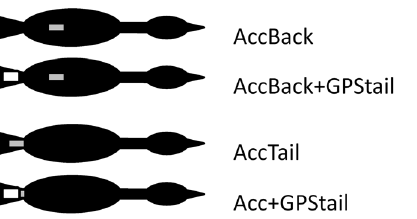
Figure 1. Dorsal placements of external devices fitted to gannets. Schematic representation of a gannet wearing devices at different positions as to test the effect of device mass and placement on flying behaviour and energetics. NB All devices placed on the tail were attached to the underside of 2 to 3 central feathers using Tesa